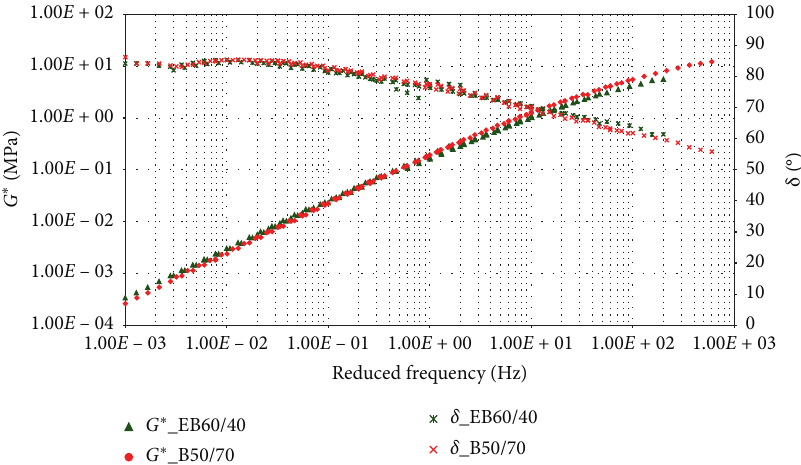
Figure 8: Master curve of bitumen and bitumen vontained in emulsion.